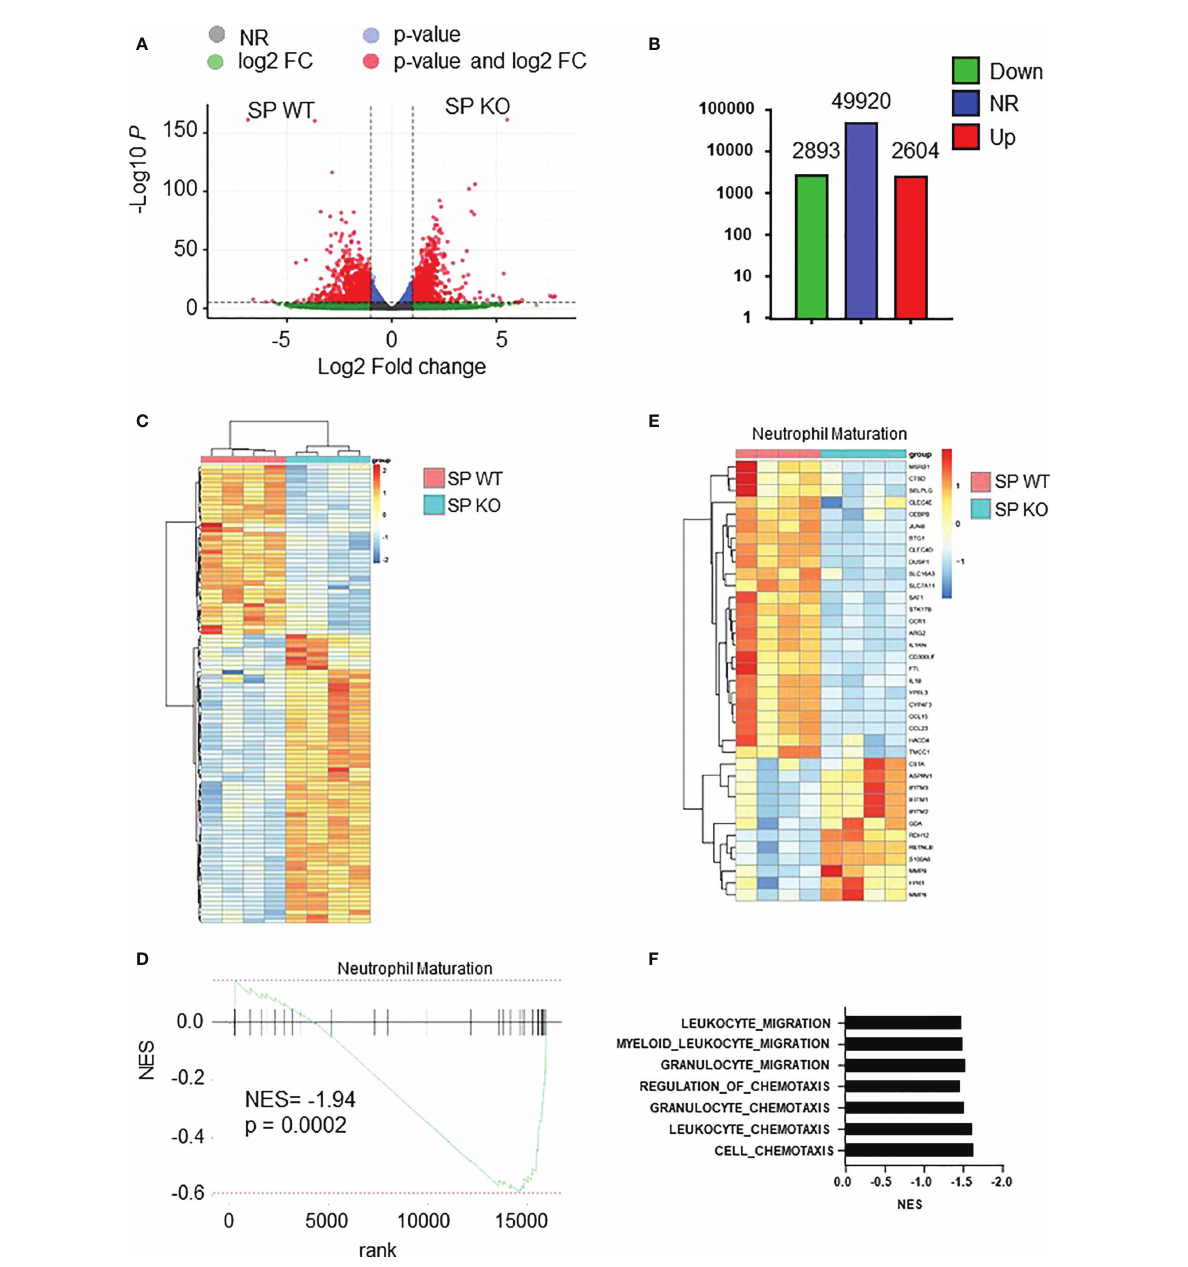
FIGURE 6 Cxcr2-/- neutrophils display decreased maturity at the transcriptomic level. (A) Volcano plot showing the global changes in RNA expression patterns for spleen neutrophils isolated from Cxcr2-/- (SP KO) versus WT (SP WT) animals. Data represent analysis of cpm estimates with a log of fold change of more than 1.5 fold and p< 0.05 of 4 animals per group. Grey dots: NR: non-regulated genes; Green dots: genes with a log of fold change of more than 1.5 fold; blue dots: genes with a p-value <0.05; red dots: genes with a log of fold change of more than 1.5 fold and p< 0.05. (B) Number of differentially regulated genes for the spleen neutrophils. Up: genes up-regulated in spleen isolated from Cxcr2-/- versus WT animals. Down: down-regulated genes. NR: non regulated genes. (C) Simpli fi ed Heatmap of spleen Cxcr2-/- versus WT neutrophils. (D) Normalized enrichment score (NES) after GSEA analysis of the transcriptome of spleen neutrophils isolated from Cxcr2-/- versus WT animals according to Neutrophil maturation of Xie et al. (36). (E) Heatmap of the signi fi cantly regulated genes (p<0.05) of Neutrophil maturation signature. (F) Cluster of chemotaxis and migration GSEA analysis from Cxcr2-/- versus WT animals according to Biologic process GO: Cell- chemotaxis (NES= -1.64; q= 0.0002), Leukocyte-chemotaxis (NES= -1.62; q= 0.001), Granulocyte chemotaxis (NES= -1.53; q= 0.029), Regulation of Chemotaxis (NES = -1.46; q = 0.013), Granulocyte migration (NES= -1.54; q=0.025), Myeloid-leukocyte-migration (NES= -1.50; q= 0.012), leukocyte-migration (NES = -1.48; q=